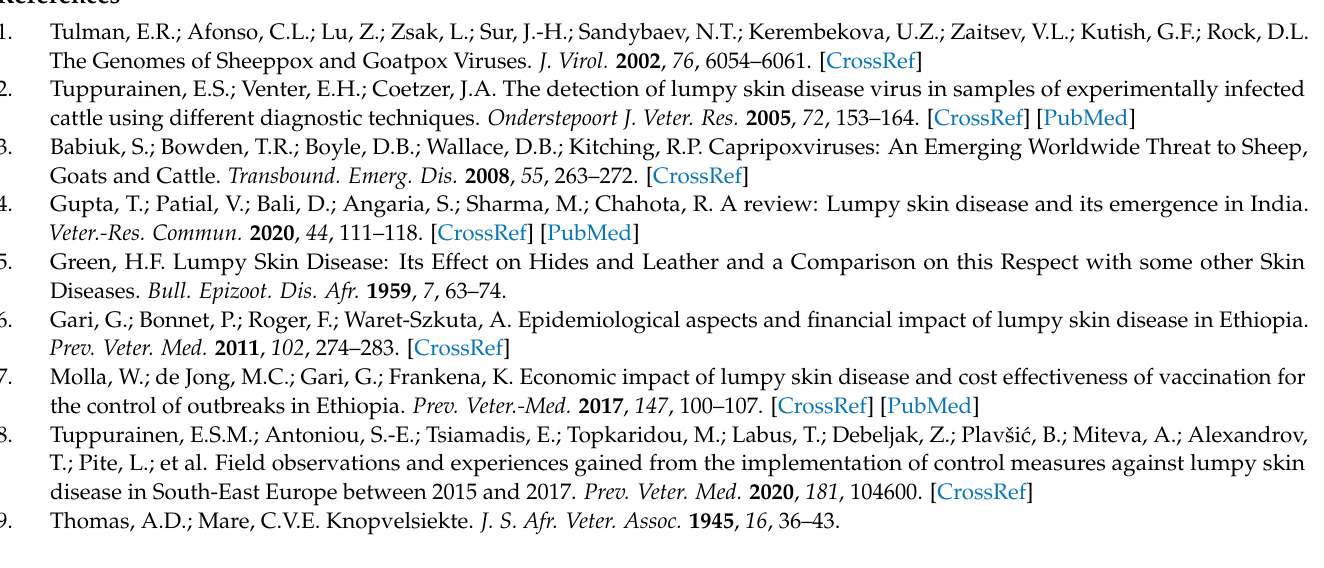
control animals averaged per trial. Figure S2: Total clinical scores of control animals. Figure S3: Viremia control groups, LSDV con1 and con2. Figure S4: IPMA and ELISA results of the control animals. Figure S5: Averaged total clinical score of the LSDV LAV and Inac groups after vaccination. Figure S6: IFNg results of the LSDV LAV 18 (a), 12 (b) and 6 (c). Figure S7: IFNg results of the LSDV Inac 12 (a) and 6 (b). Table S1: PCR results of organ and tissue samples of the unvaccinated control groups. Table S2: VNT1 and VNT2 results of both control groups. Table S3: real-time PCR results (pan capripox) of organ and tissue samples of the three LSD LAV groups. Table S4: Antibody titers of the LSDV LAV groups as determined by IPMA. Table_S5: real-time PCR results (pan capripox) of organ and tissue samples of the two LSD Inac groups. Table S6: Antibody titers of the LSDV Inac groups as determined by